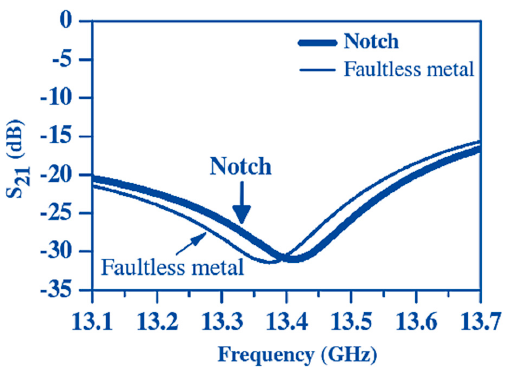
Figure 10. Measured transmission parameter S 21 of the 10- µ m-wide HF stub filter set at d = 50 µ m above a faultless metal plate and a 200- µ m-wide surface notch (from [29]; copyright © 2008; redesigned with permission).